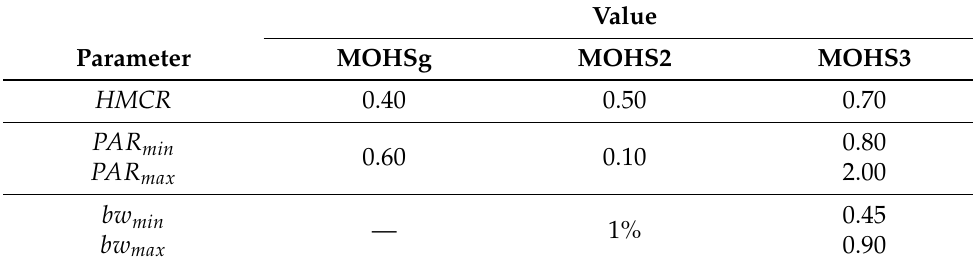
Table 2. Parameters for problem